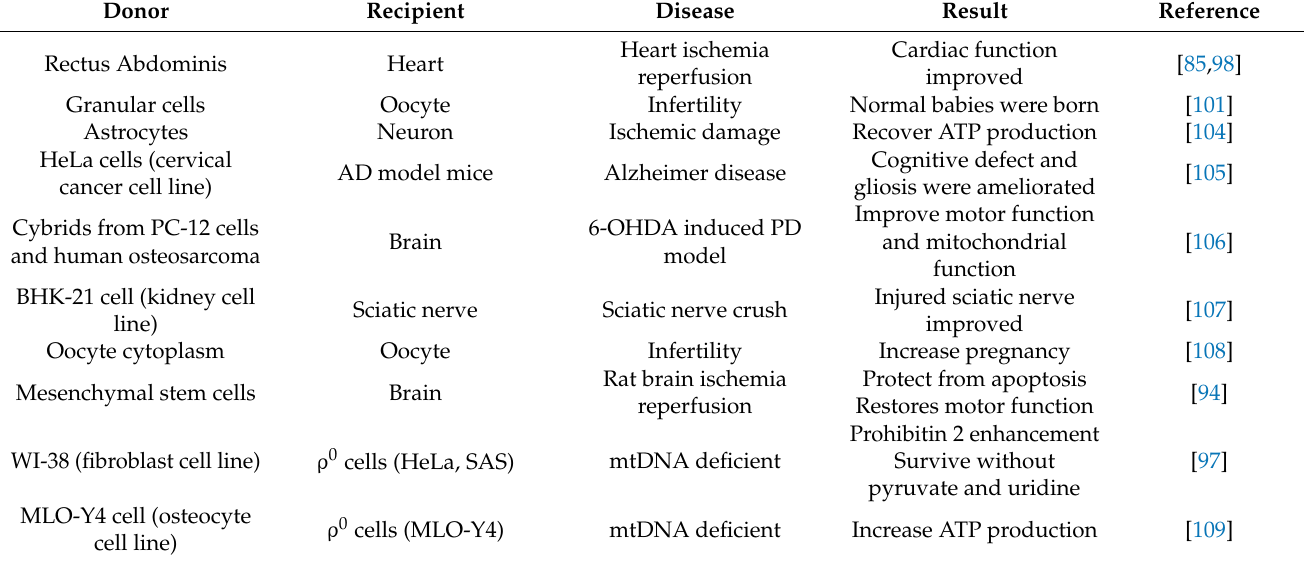
Table 1. Preclinical and clinical studies about mitochondrial